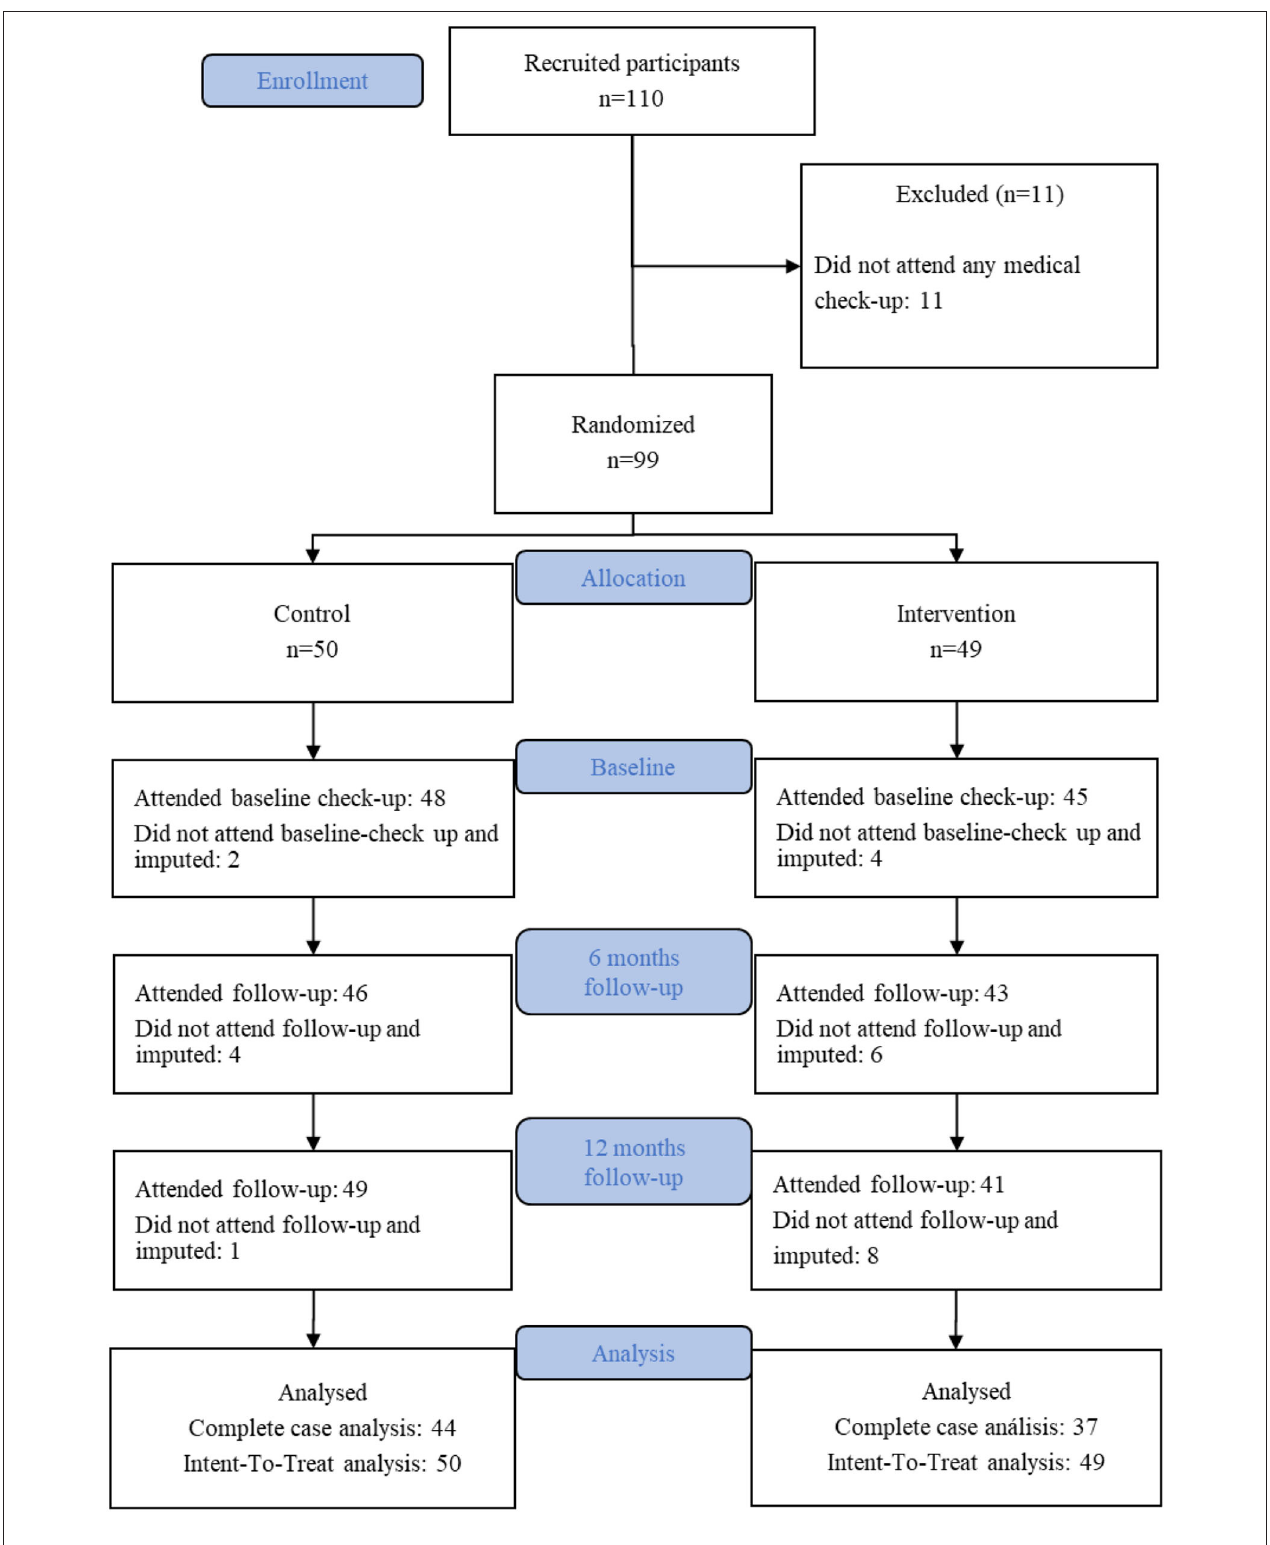
FIGURE 1 | CONSORT diagram of the